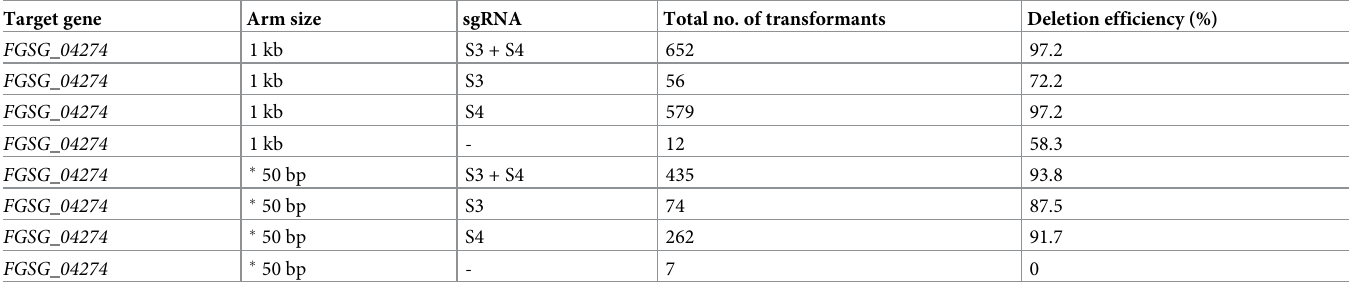
Table 4. High efficiency of gene deletion via RNP transformation was tested by FGSG_04274 for verification. Deletion mutants were identified by the dark red color and abnormal shapes of the colonies. � 50 bp indicates that GEN is amplified by 70 bp primers, which contain 50 bp arms homologous to sequences upstream or down- stream from FGSG_04274